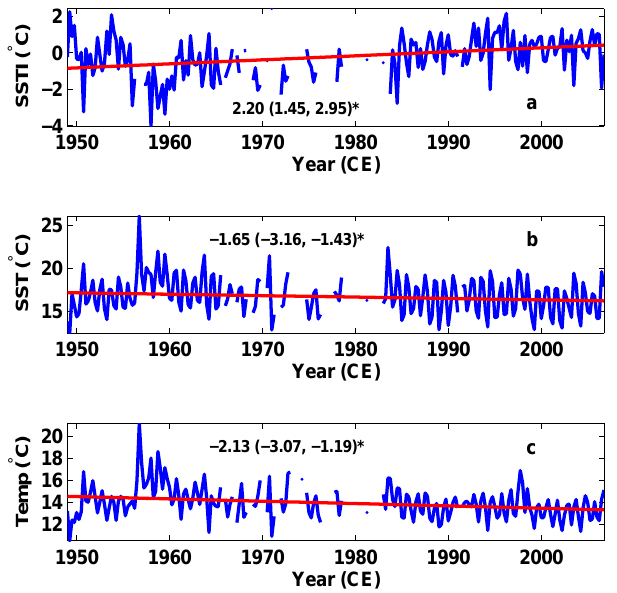
Fig. 8. (a) Linear trend of the upwelling index derived from the CALCOFI (Bograd et al., 2003) SST dataset estimated using the method of least squares and using the datapoints shown in Fig. 2. (b) Linear trend of SST in coastal California estimated from the CALCOFI dataset. The trend indicates a significant cooling over the last 45 years. (c) Linear trend of the coastal temperature aver- aged over top 100m of the water column off California estimated from the CALCOFI dataset. The value of the slope and its 95% con- fidence interval are given in each panel (in units of 10 − 2 ◦ Cyr − 1 ). A ∗ indicates that the slope is statistically significant at the 0.05 level.